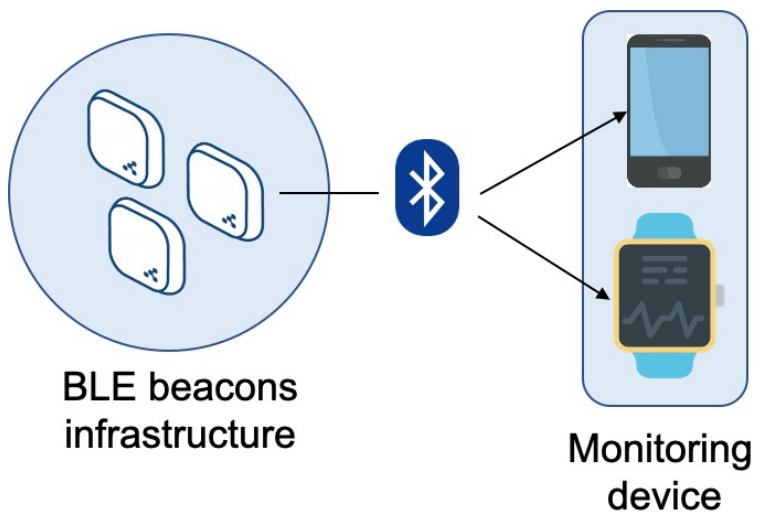
Figure 3. Main components of a BLE system.